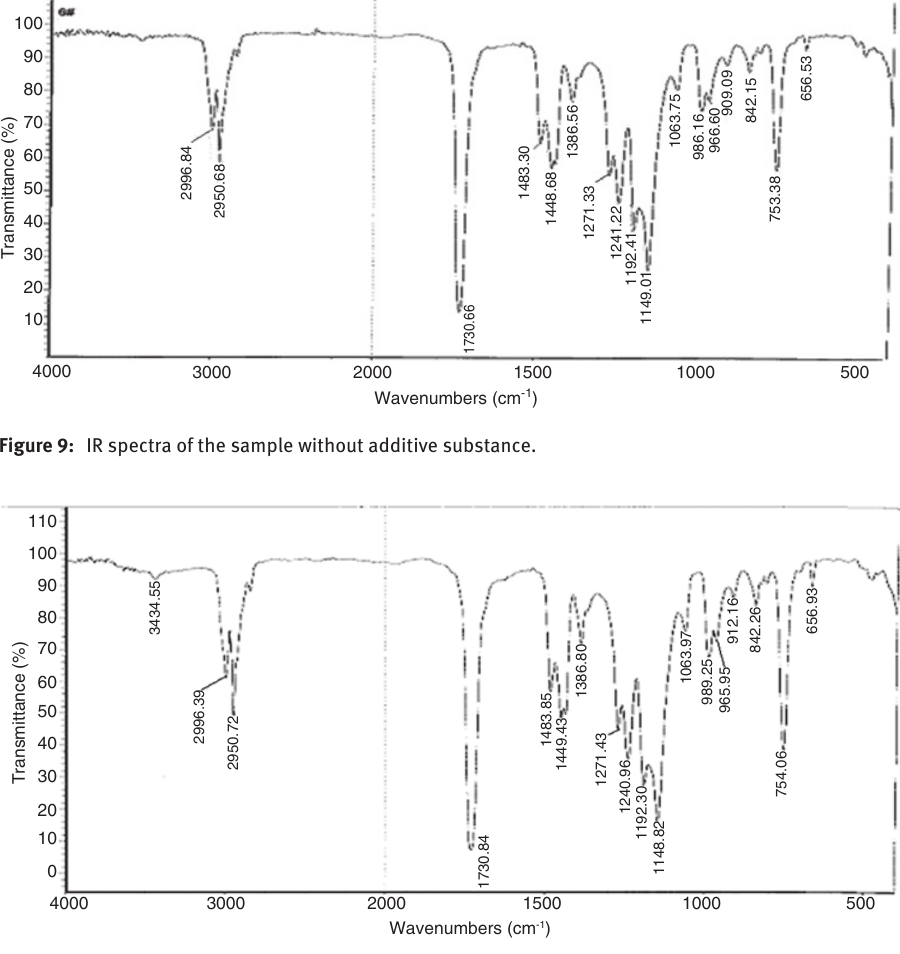
Figure 10: IR spectra of the sample containing additive substance.